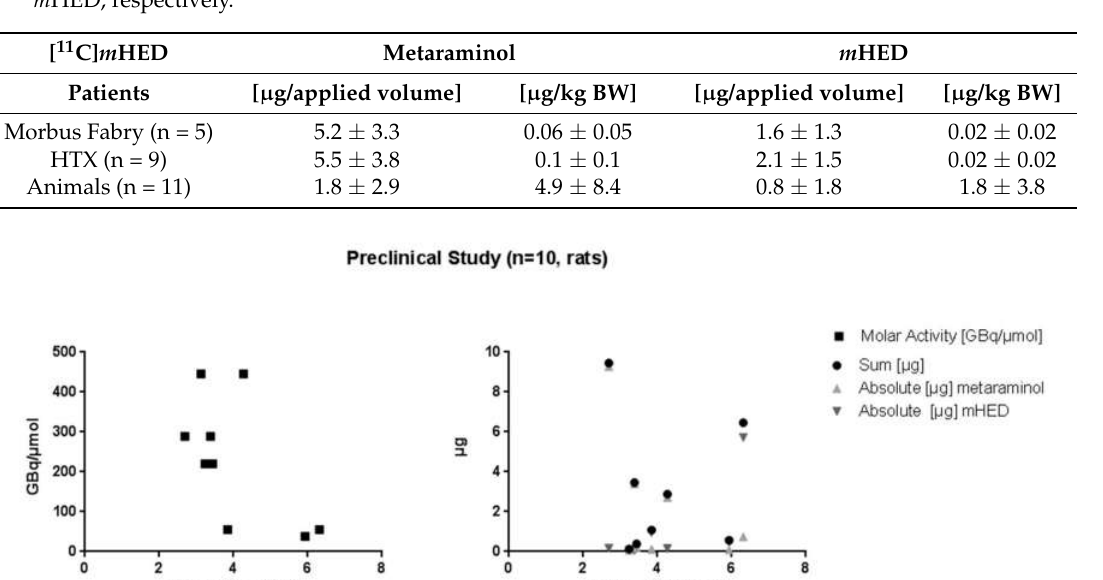
within all applied masses.